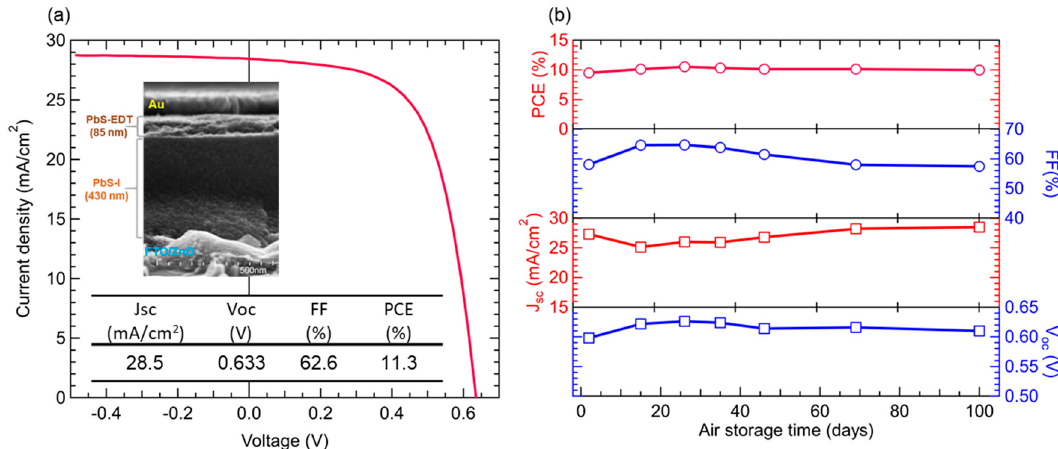
Figure 5. ( a ) Device performance and the cross-section SEM image of the best performing solar cell; ( b ) the time course of air stability test of unencapsulated solar cells treated at 80 °C.